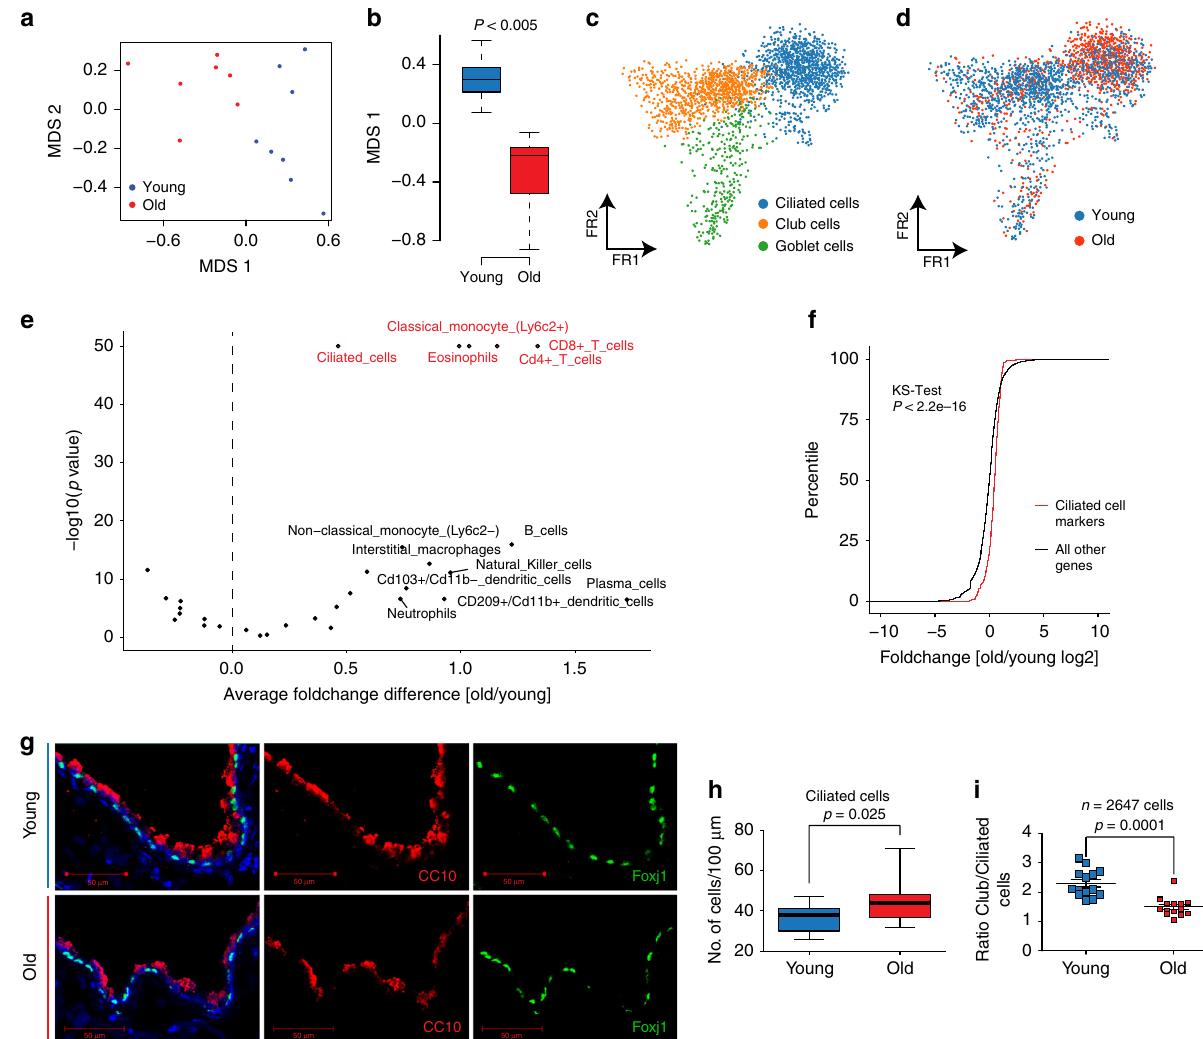
Fig. 4 Cell-type deconvolution reveals increase of ciliated cells in airways of old mice. a The multidimensional scaling (MDS) plot shows the mouse-wise euclidean distances of cell-type proportions for the two age groups. b The box plot shows the signi fi cant difference in the multidimensional scaling component 1 of cell-type proportions between young ( n = 8) and old ( n = 7). The box represents the interquartile range, the horizontal line in the box is the median, and the whiskers represent 1.5 times the interquartile range. c The Fruchterman – Reingold (FR) embedding of the airway epithelial cells in the dataset reveals distinct clusters of airway cell identity. d The indicated color code shows the distribution of young and old cells to the three clusters presented in ( c ). Note the increased density of old cells in the ciliated cell cluster. e The volcano plot shows negative log10 enrichment p values of cell-type marker signatures in the differential expression results of the bulk RNA-seq data from young and old mice. f The empirical density plot shows signi fi cant enrichment for ciliated cell-type marker genes (red line) compared to all other genes (black line) in the distribution of fold changes derived from the bulk differential expression analysis. g Club and ciliated cells were stained using a CC10 and Foxj1 antibody respectively (scale bar: 50 µ m). h The boxplot depicts the quanti fi cation of ciliated cells from counting a total of 2647 club and ciliated cells in 14 individual airways of n = 2 mice of each indicated age group. i Ratio of ciliated to club cells in 14 individual airways of two mice for each indicated age group. The p values are derived from an unpaired, two- tailed t -test using Welch ’ s stress signaling that maintains cellular persistence and fosters independent fl ow cytometry experiment on epithelial cells survival and cellular functionality under distinct pathological marked by Epcam expression (Fig. 7k, l). Elevated MHC class I conditions 40 . levels likely result in increased presentation of self-antigens to the immune system and are consistent with our observation of a prominent interferon-gamma signature in old mice (Fig. 3d), which is known to activate MHC class I expression 39 . Type-2 pneumocytes of old mice featured a highly signi fi cant upregula- tion of the enzyme Acyl-CoA desaturase 1 ( Scd1 ), which is the Fig. 5 for gating strategy) and performed bulk RNA-seq on these fatty acyl Δ 9-desaturating enzyme that converts saturated fatty isolated cell types from young ( n = 4) and old ( n = 4) mice. acids into monounsaturated fatty acids (Fig. 7c). The age- Principal component analysis (PCA) was performed using the dependent upregulation of Scd1 in type-2 pneumocytes may have scRNA-seq-derived signatures of alveolar macrophages and type- important implications since Scd1 is thought to induce adaptive 2 pneumocytes. Gene expression pro fi les of fl ow-sorted epithelial